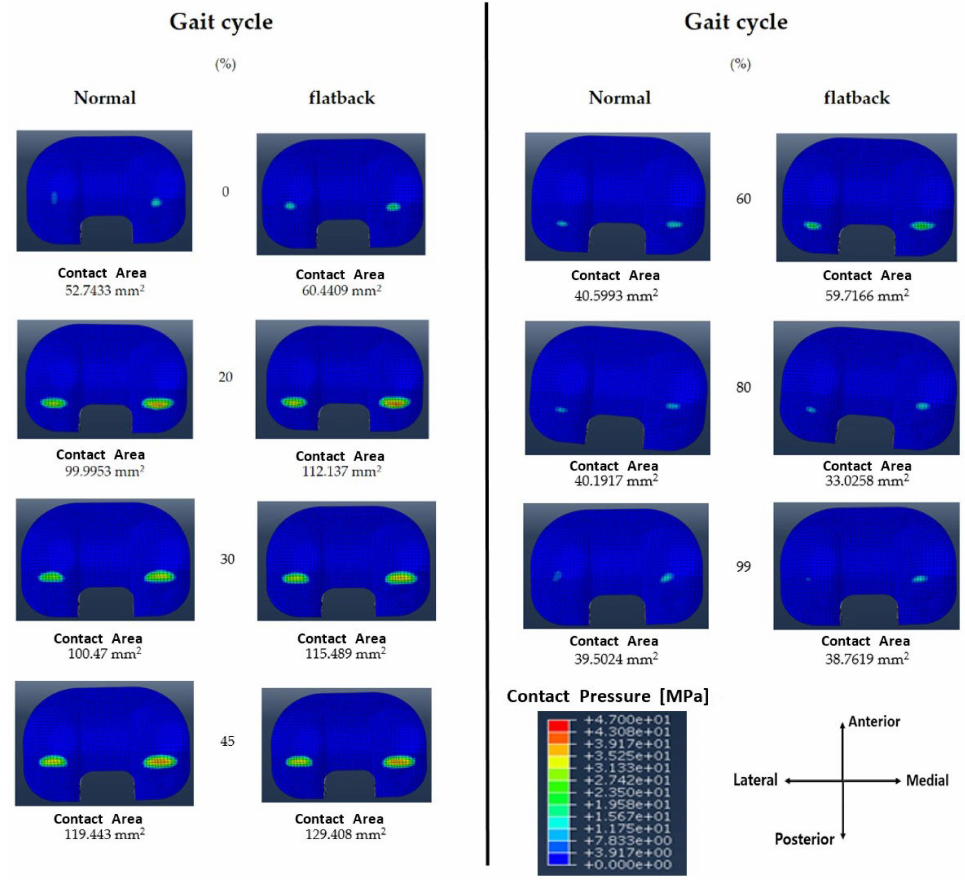
Figure 12. Contact pressure distribution of tibial insert for normal and flatback gait